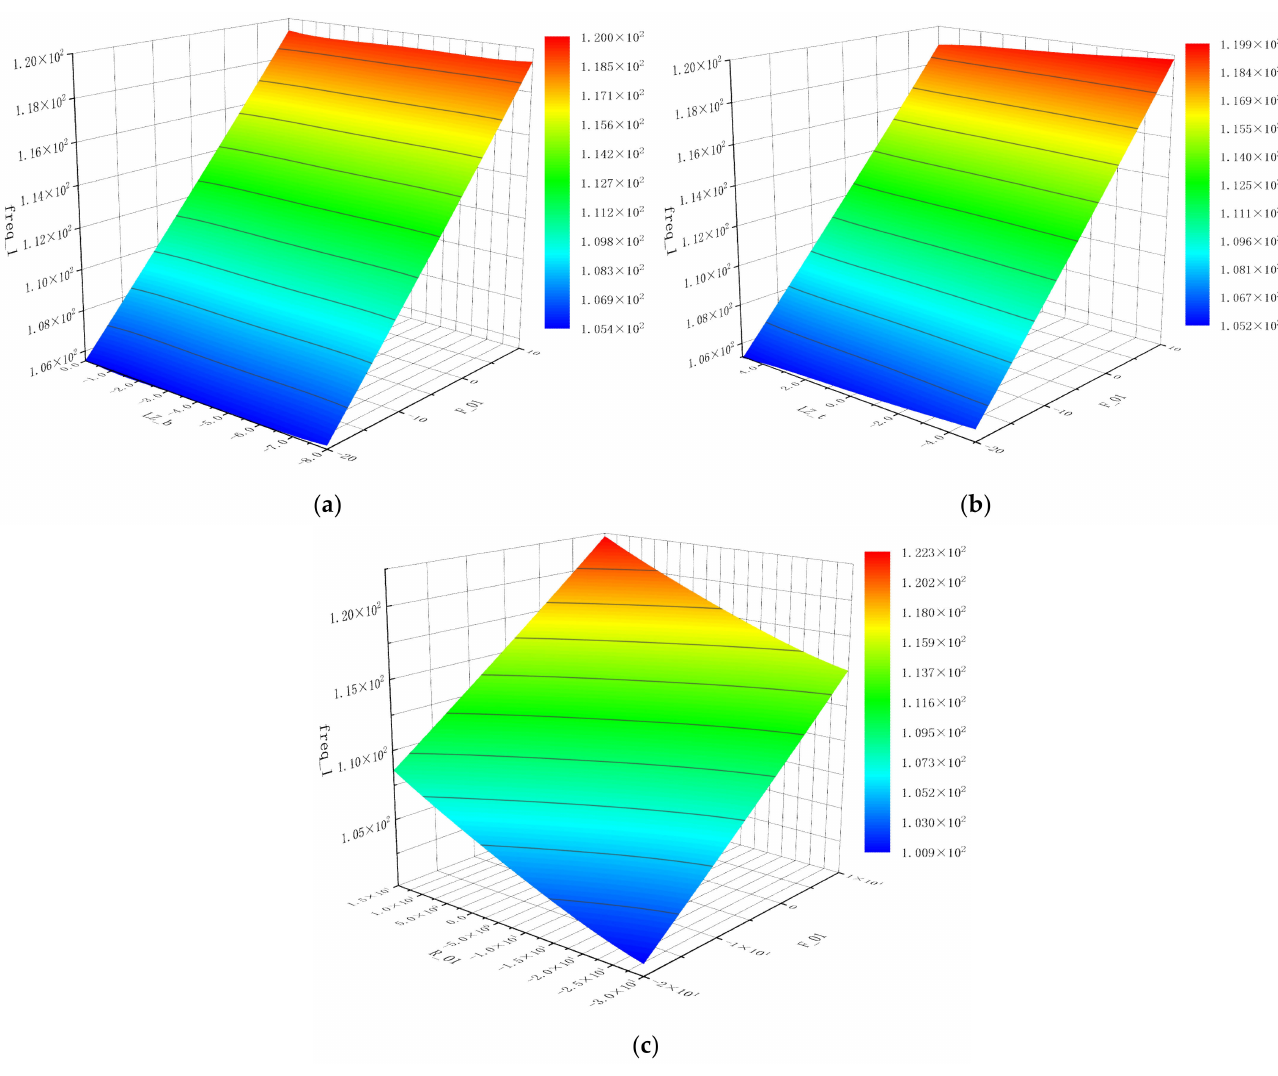
Figure 12. First order frequency response and variable response surface approximation model